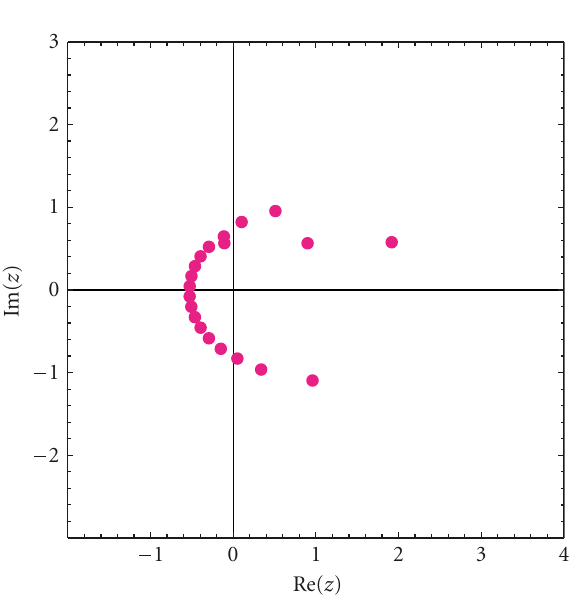
Figure 4.10 . Zeros of E 20, q , w ( x